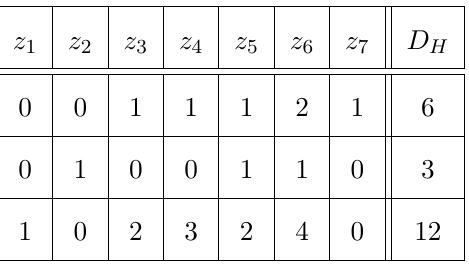
Table 8 . Weights for polytope with ID 57 at h 1 , 1 = 3